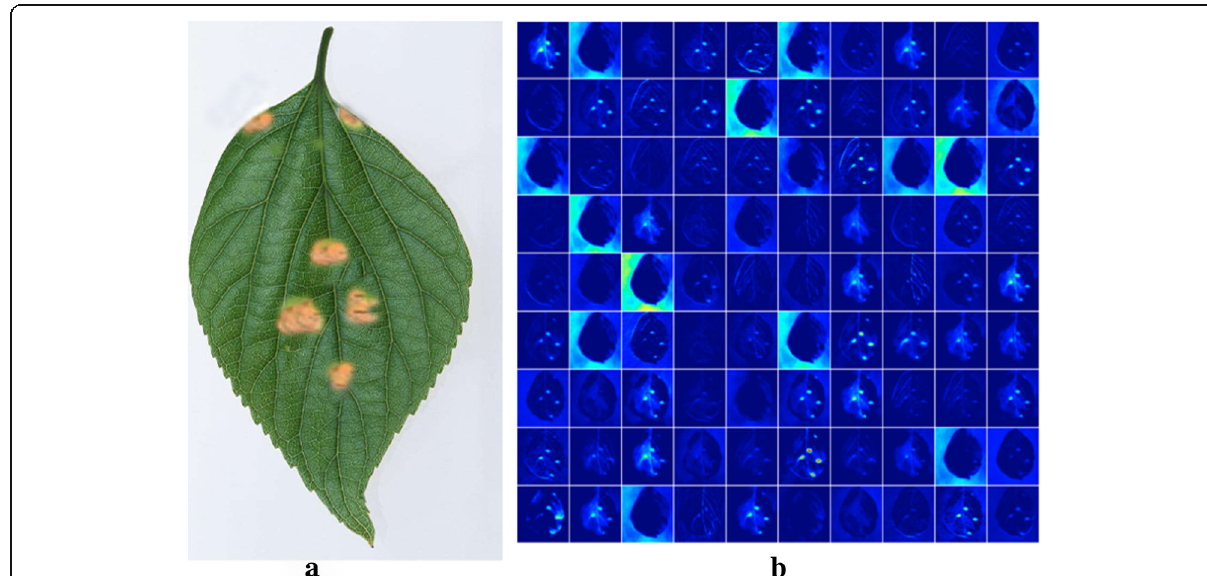
Fig. 5 Activation visualization: ( a ) original image; and ( b ) the learned weights by the first layer. As shown in Fig. 5, the model proposed by GoogLeNet Inception is used to extract the pathological features from the original image, which improves the automatic feature extraction in multidimensional space. Therefore, the proposed model based on CNN has better recognition ability for rape leaf